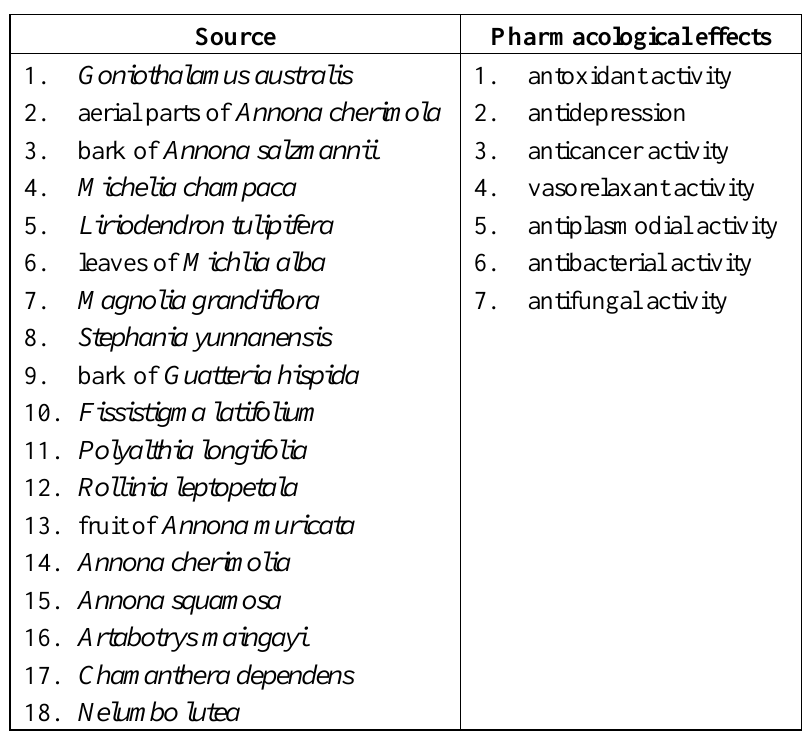
Table 1. Anonaine isolated from plants and its pharmacological